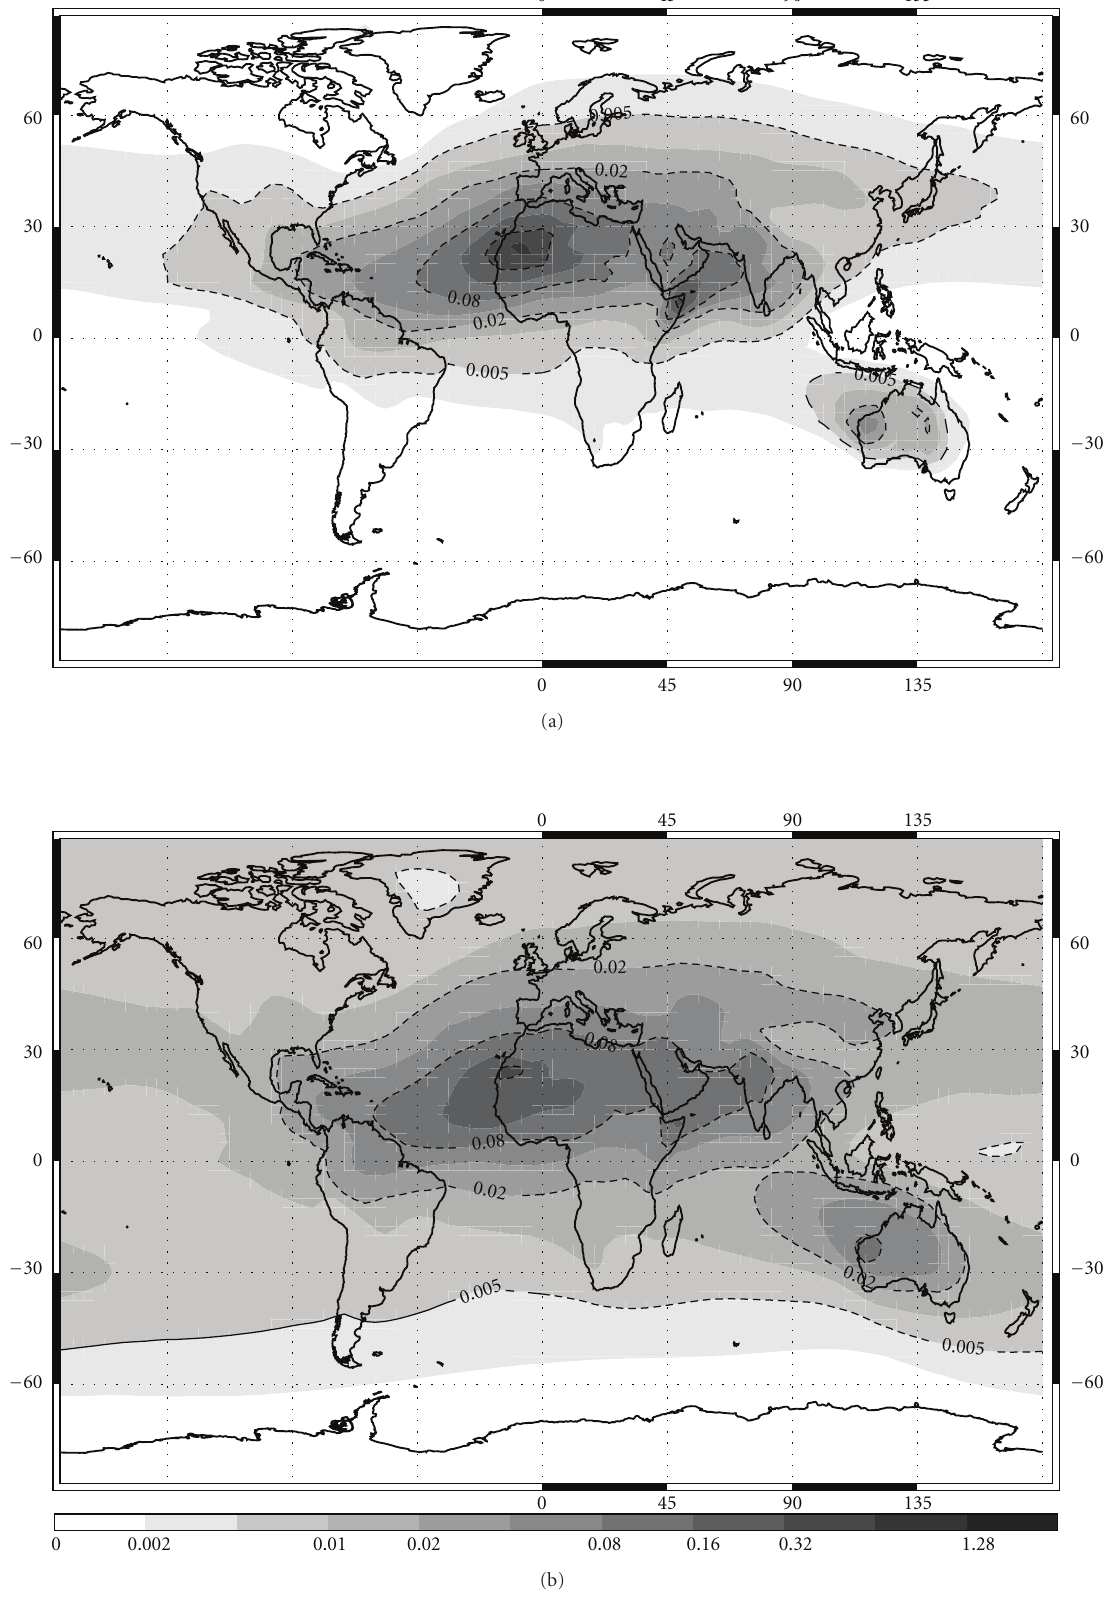
Figure 3: Annual mean AOD at 550nm for (a) CLIM and (b) DEAD averaged over the last 16 years of each model